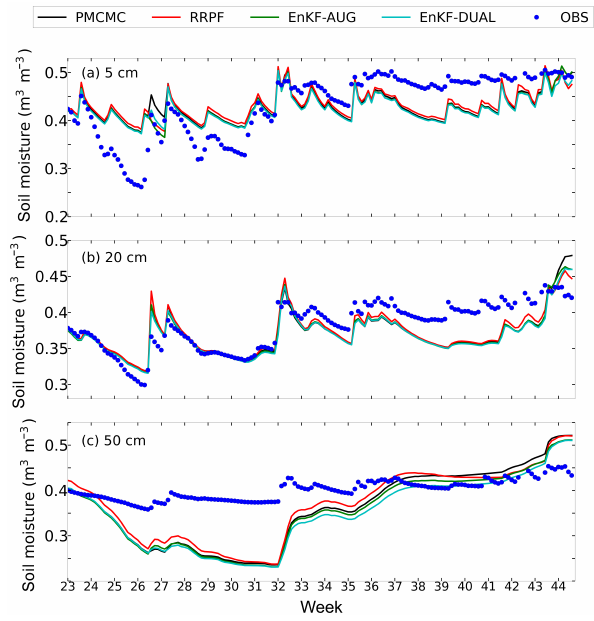
Figure 6. Evaluation period: observed (blue dots) and VIC-3L sim- ulated time series (solid lines) of soil moisture content at depths of (a) 5cm, (b) 20cm, and (c) 50cm in the Rollesbroich site. Color coding is used to differentiate between the results of PM- CMC (black), RRPF (red), EnKF-AUG (green), and EnKF-DUAL (cyan). The first days of weeks 23 and 44 are 1 August 2012 and 26 December 2012,